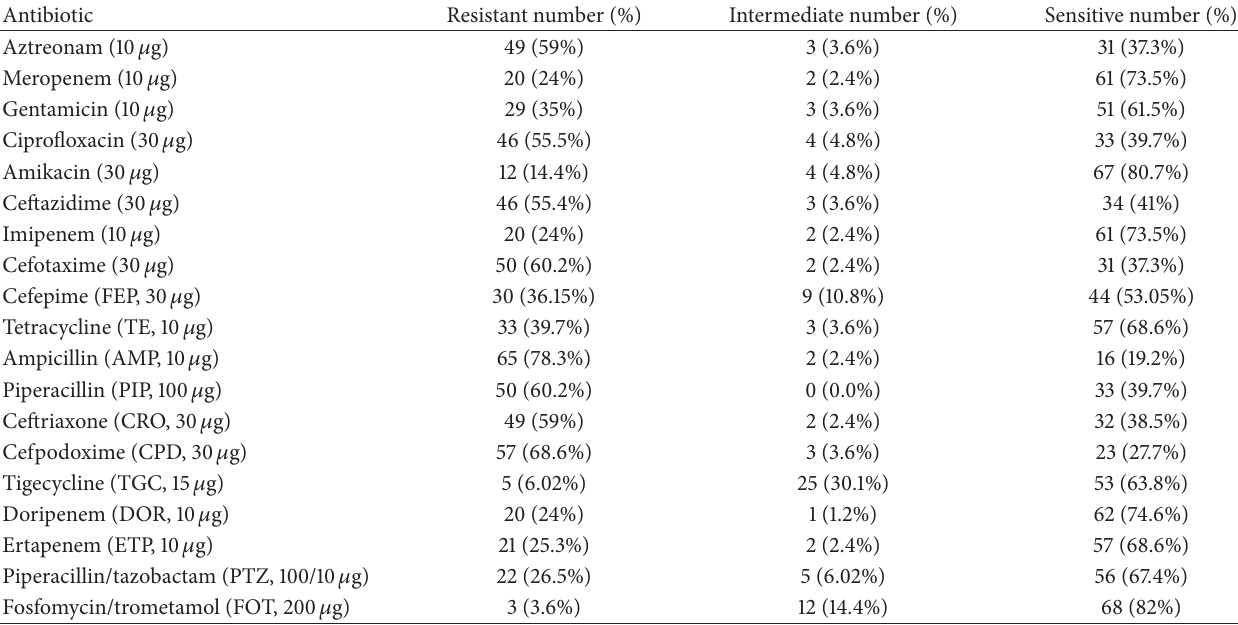
Table 1: Antimicrobial susceptibility testing results of 83 isolates of K. pneumoniae collected from Mofid Children and Taleghani Hospitals, Tehran, Iran.